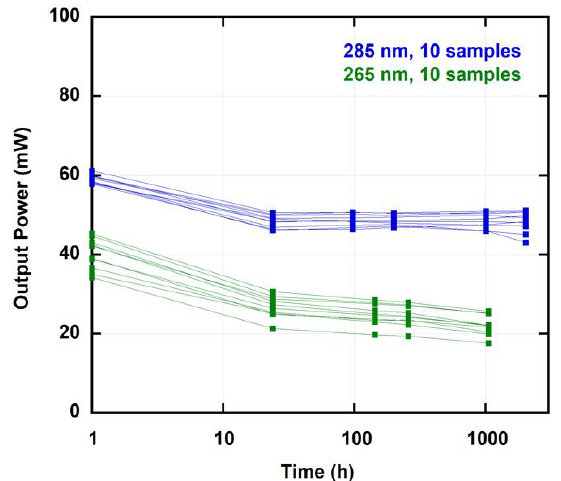
Figure 14. Reliability tests for 265 and 285 nm LEDs. The tests were carried out at 350 mA (>100 mA/cm 2 in the junction area), which is 3.5 times higher than 100 mA in our previous report [13], demonstrating the robustness of the AlGaN-based uneven QWs.